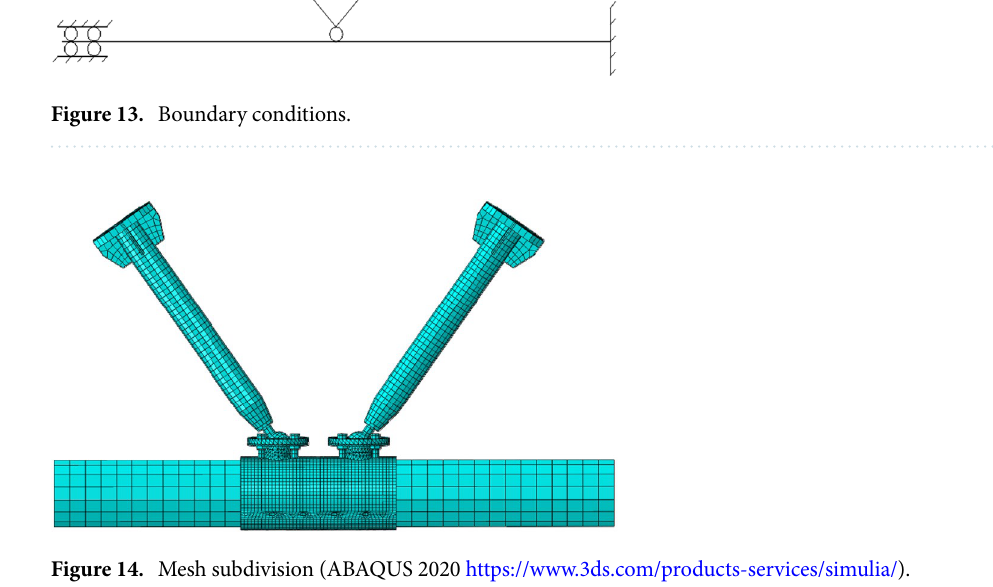
Figure 14. Mesh subdivision (ABAQUS 2020 https:// www. 3ds. com/ produ cts- servi ces/ simul